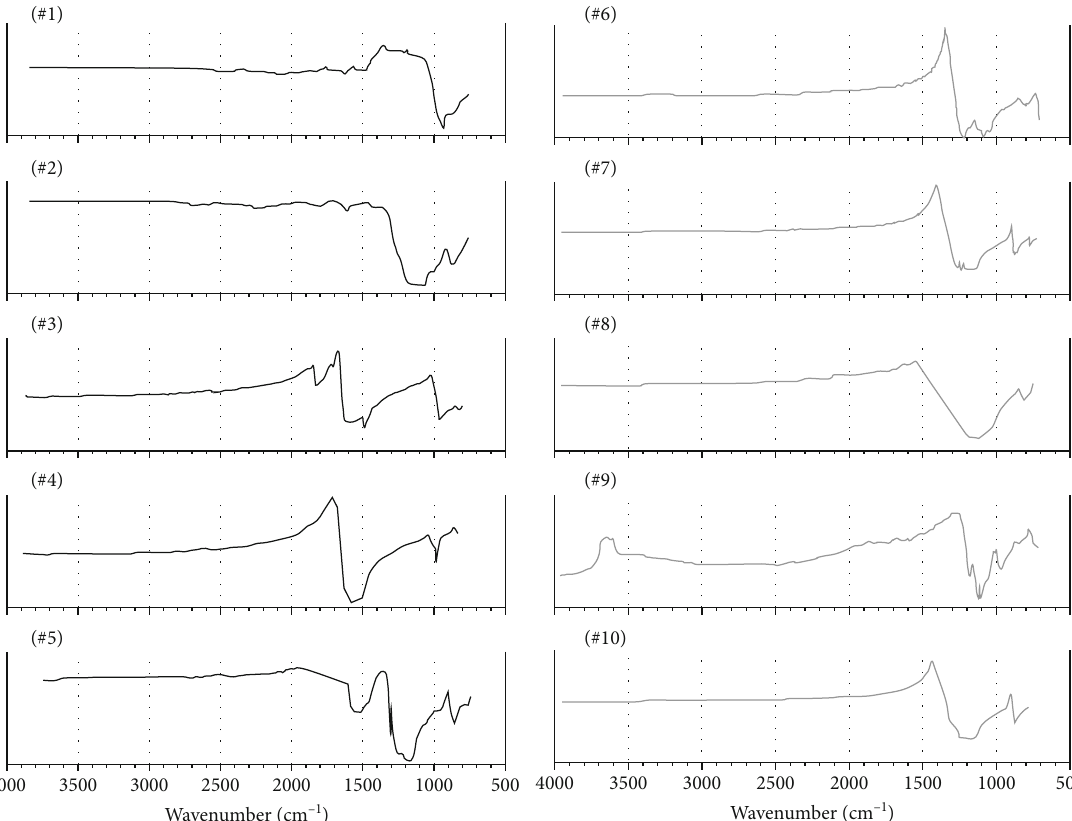
Figure 4: Micro-FTIR spectra of selected measurement spots, see location in Figures 1(c) and